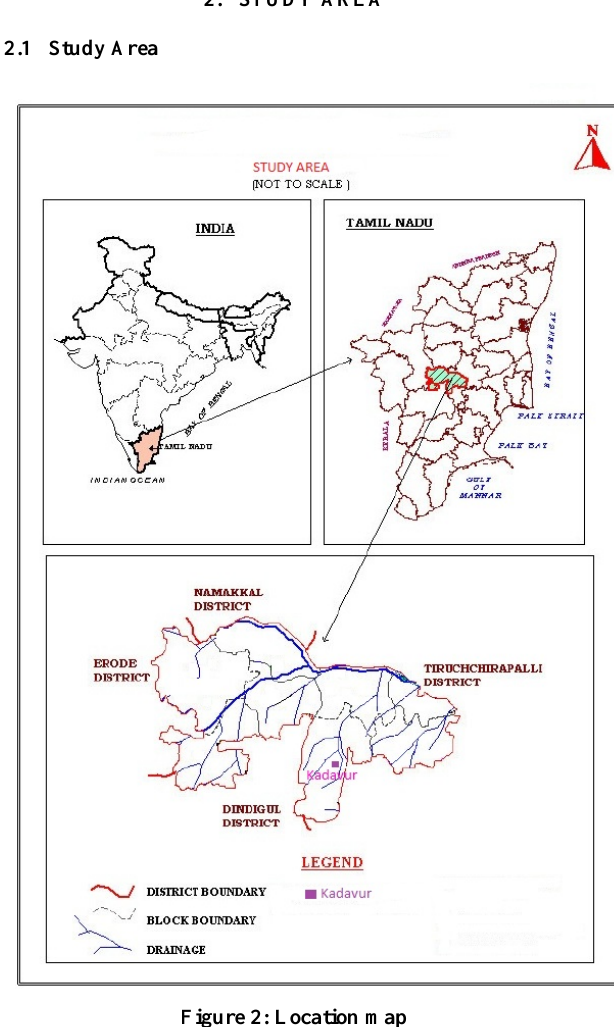
Figure 2: Location map Karur district is divided into 4 taluks. The taluks are further divided into 8 blocks, which further divided into 203 villages.